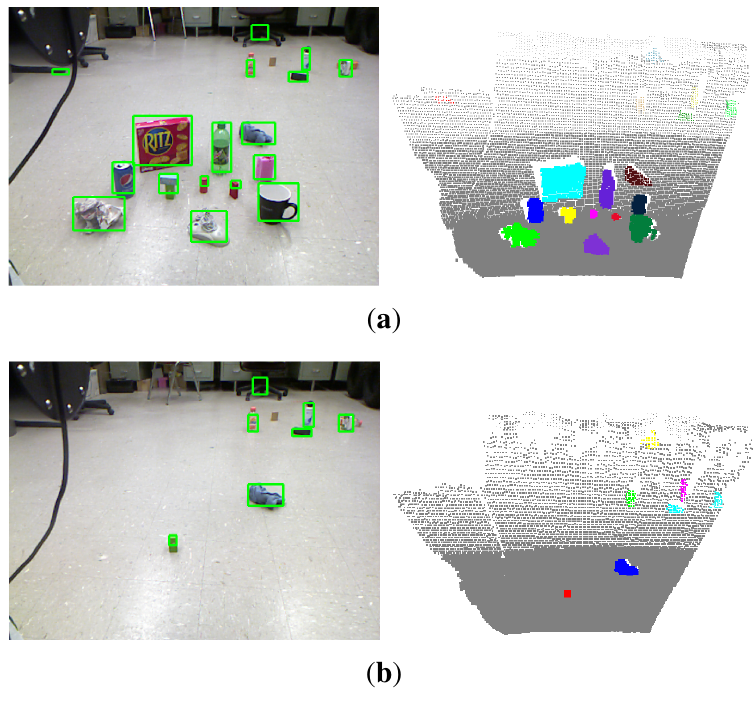
Figure 11. A typical experimental scene seen from the robot. ( a , b ) show the detected objects before and after the robot picking up all detected objects within its manipulation range,